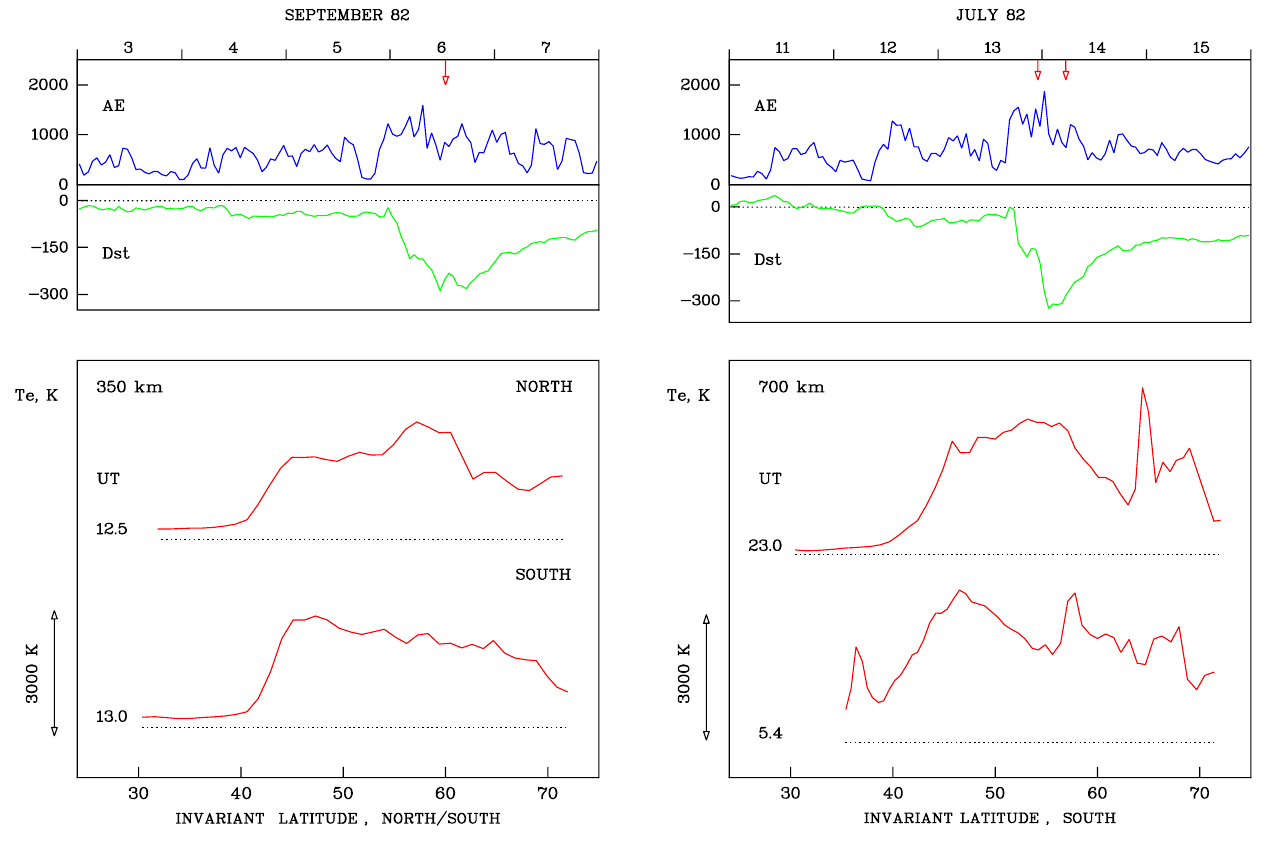
Fig. 15. Latitudinal variation of the electron temperature during storm conditions. In the upper part of the figure, the AE and Dst indices are used to describe the geomagnetic activity during the storm of 6 September 1982. During the main phase of this storm, electron temperature profiles were obtained by the DE-2 satellite in both hemispheres. These profiles are shown in the lower part of the figure. The approximate universal times of the observations are in- dicated next to each profile, and also by an arrow in the AE panel of the figure. The dotted reference lines mark the 1000K level, and the temperature scale is indicated by an arrow on the left-hand side. Using a constant temperature gradient of 1K/km, all temperature values have been adjusted to a common altitude of 350km. Solar local time of observation is approximately 24h and the magnetic local time about 23h. See also Fig. 2.